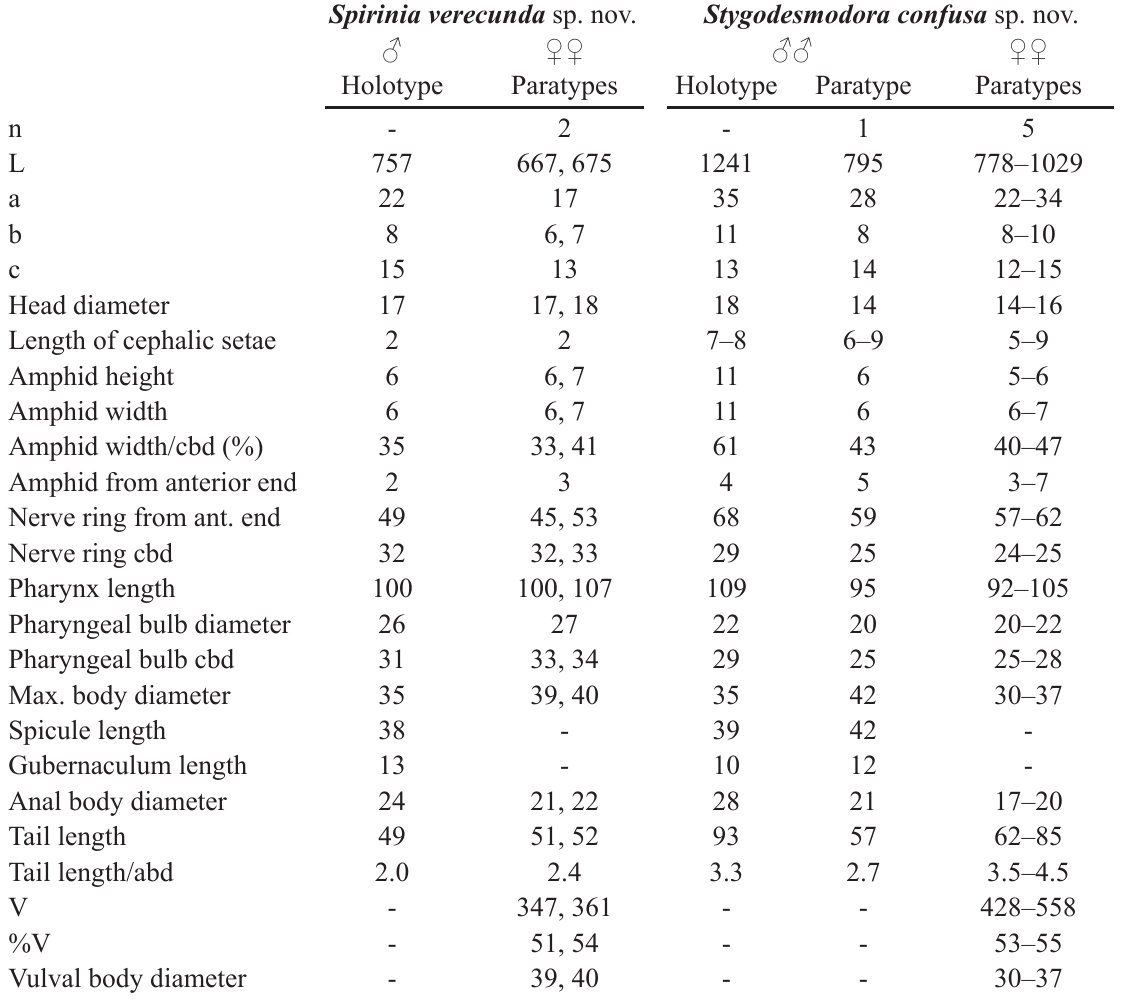
Table 1. Morphometrics ( µ m) of Spirinia verecunda sp. nov. and Stygodesmodora confusa sp. nov. — a, body length/maximum body diameter; abd, anal body diameter; b, body length/pharynx length; c, body length/tail length; cbd, corresponding body diameter; V, vulva distance from anterior end of body; %V, V/total body